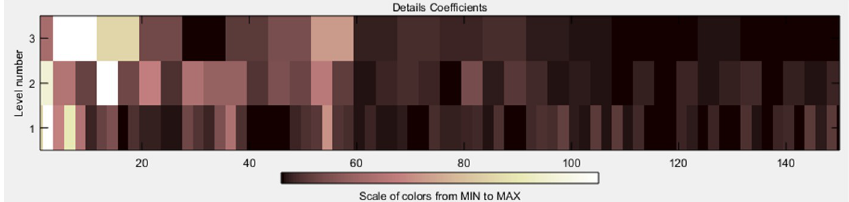
Figure 21. Detail coefficients related to the upward-downward movement.